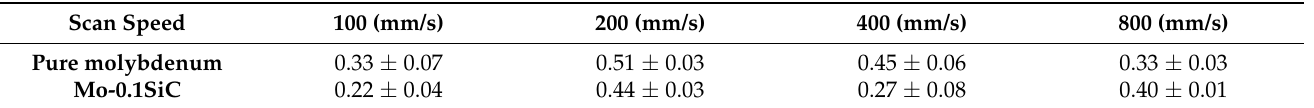
Table 3. Fraction of boundaries with a rotation angle greater than 15 ◦ for pure molybdenum and Mo-0.1SiC specimens.